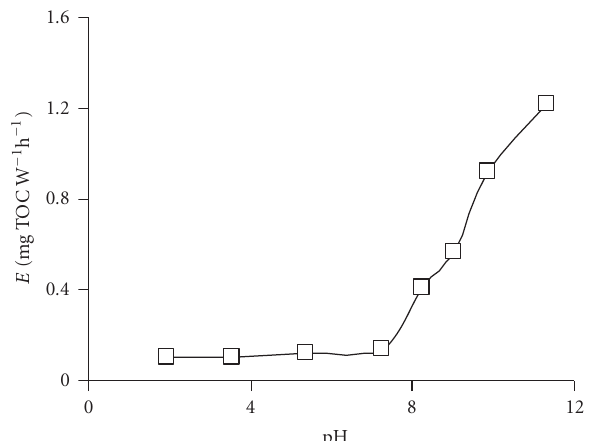
Figure 1: Dependence of PCO e ffi ciency on pH for synthetic solu- tion of MA (the e ffi ciency was calculated for 24-hour treatment of MA solutions).